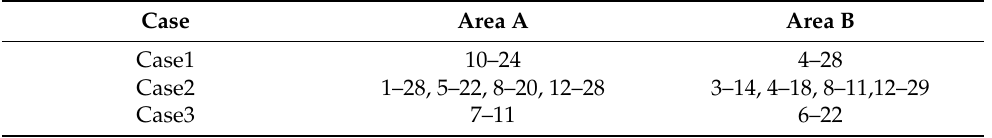
Figure 8. The cloud coverage of Sentinel-2 images in the study areas in 2020. ( a ) Area A; ( b ) Area B. (Low means that the cloud coverage of the Sentinel-2 image is ≤ 10%, Middle means that the cloud coverage of the Sentinel-2 image > 10% and ≤ 60%, and High means that the cloud coverage of the Sentinel-2 image > 60%). Table 5. The corresponding dates of the images selected in Area A and B under different cases.